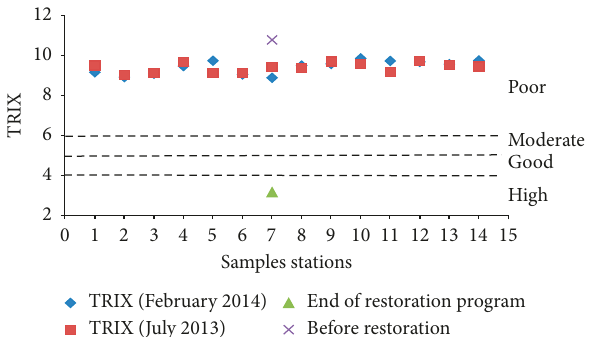
Figure 13: Variation of TRIX index [21] for the South Lagoon of